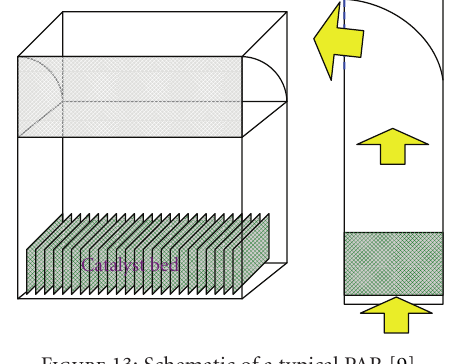
Figure 13: Schematic of a typical PAR [9].